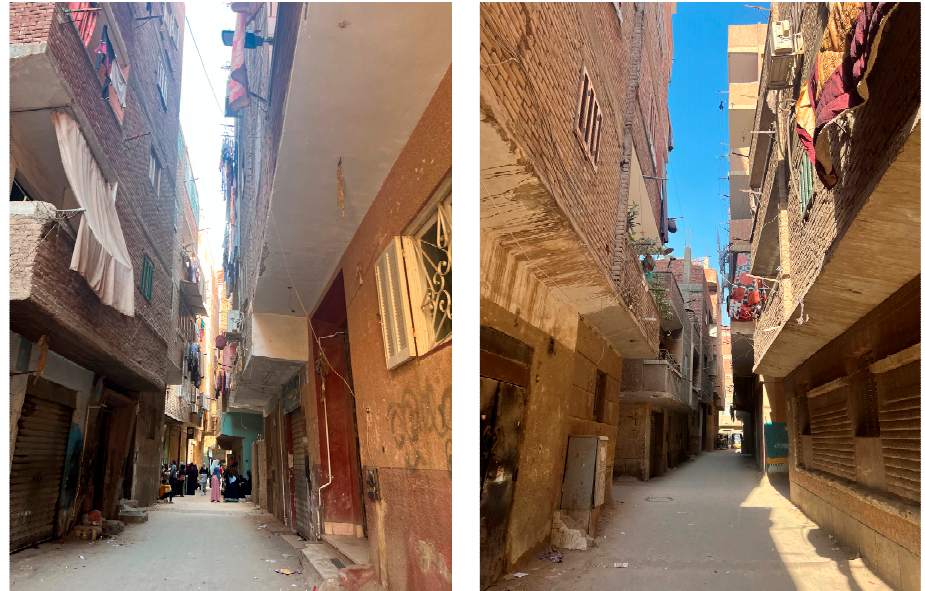
Figure 3. The narrow streets with a high density and high floor area ratio of the unplanned informal area, Marg, Greater Cairo. Taken by the authors (2022).